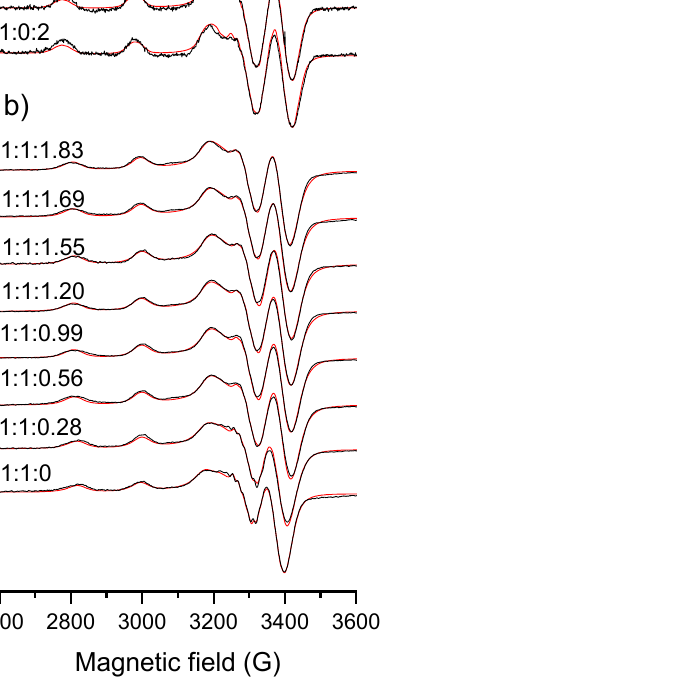
Figure 3. Experimental (black) and simulated (red) anisotropic EPR spectra recorded at 77 K for the ( a ) copper(II)-DAHK and ( b ) copper(II)-Triapine-DAHK systems at pH 7.4 after 4 h equilibration time. Numbers above the spectra indicate the copper(II):Triapine:DAHK ratios. { c Cu(II) = c Triapine = 495 μM, c DAHK = 0–908 μM; 30% ( w / w ) DMSO/H 2 O; pH = 7.4 (20 mM HEPES); I = 0.10 M (KCl)}.